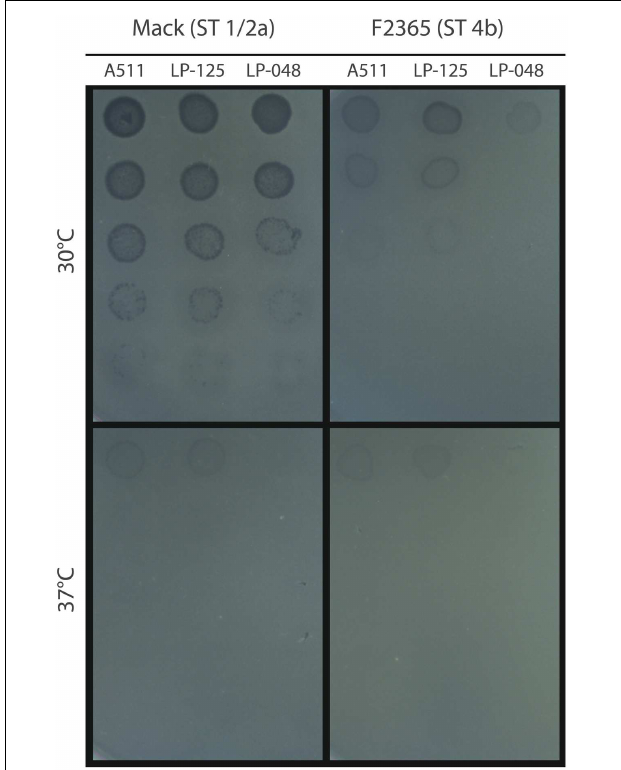
FIGURE 1 | Spot assays of phage dilutions at 30 and 37 ◦ C. Dilutions of phages A511, LP-125, and LP-048 were spotted on lawns of Mack and F2365, which were pre- and post-incubated at the temperature indicated in the figure. Phage dilutions decrease from top (most concentrated; ∼ 2 × 10 7 PFU/mL) to bottom of the figure (least concentrated; ∼ 2 × 10 3 PFU/mL). Each dilution was